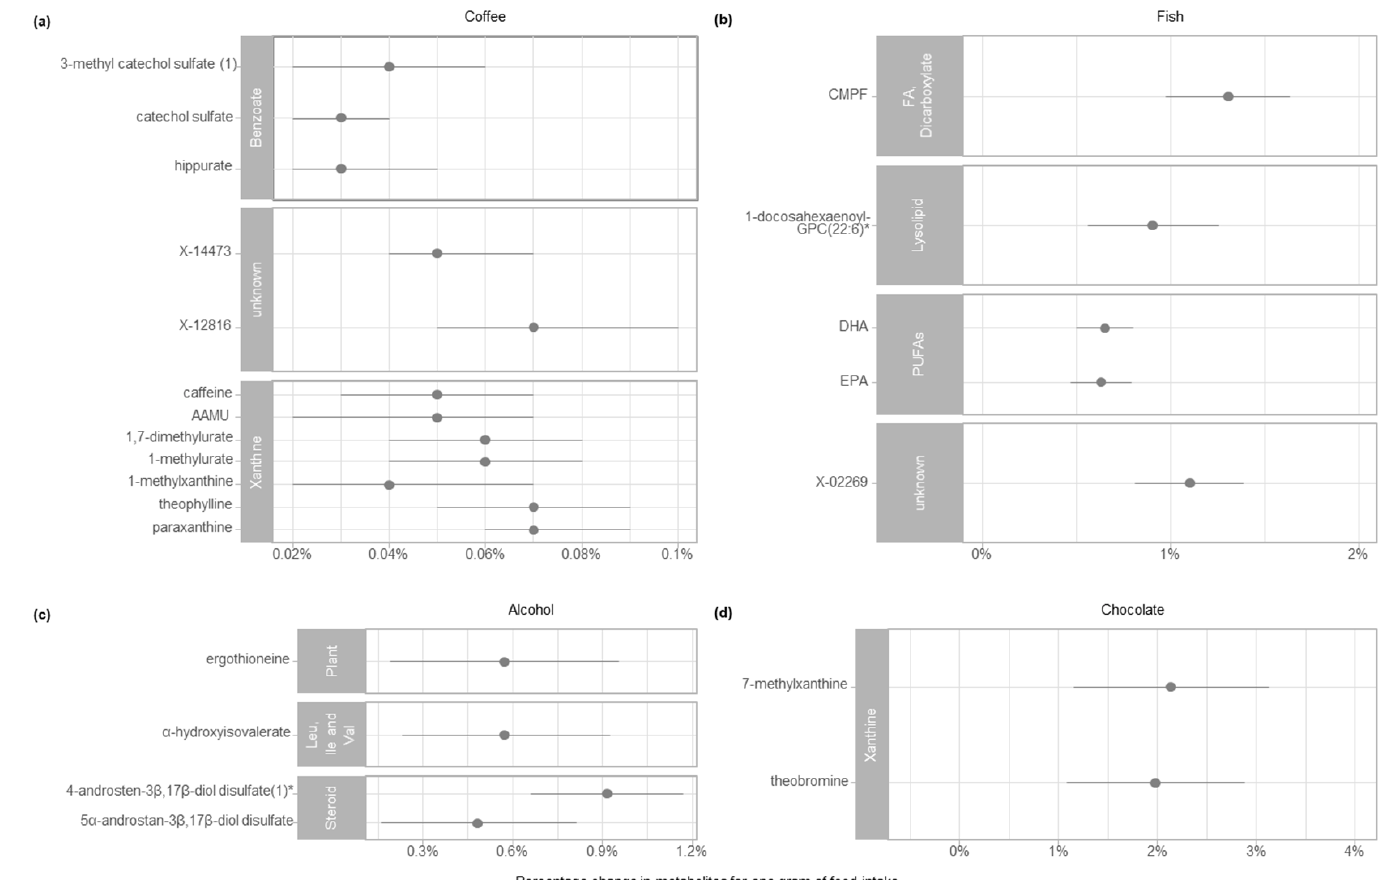
Figure 2. Confirmed food-metabolite associations for the food groups: ( a ) Co ff ee, ( b ) fish, ( c ) chocolate, and ( d ) wine. The figure represents the percentage change in metabolites for one gram change of ( a ) co ff ee, ( b ) fish, ( c ) alcohol, and ( d ) chocolate, respectively, and the subpathways of the metabolites; the estimates in percentage were generated from linear regression models with natural log-transformed metabolites as the dependent variables and ( a ) co ff ee, ( b ) fish, ( c ) alcohol, and ( d ) chocolate as the independent variable. * No pure compound was available, but we are confident in its identity. Abbreviations: AAMU, 5-acetylamino-6-amino-3-methyluracil; CMPF, 3-carboxy-4-methyl-5-propyl-2-furanpropionate; FA, fatty acid; DHA, docosahexaenoic acid; EPA, eicosapentaenoic acid; GPC, glycerophosphochcline; Leu, Ile, and Val, Leucine, isoleucine and valine metabolism; PUFAs (n-3 and n-6), polyunsaturated fatty acid (n-3 and